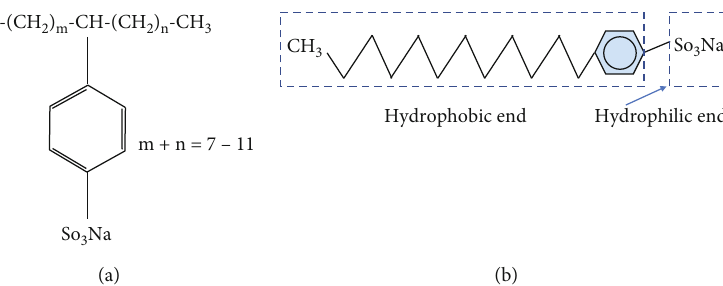
Figure 11: Molecular formula of LSA structure and schematic diagram of hydrophobic and hydrophilic ends of sulfonic acid (So3Na) group.